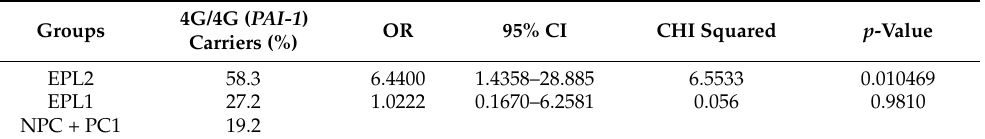
Table 5. Statistical data on the prevalence, odds ratio, 95% confidence interval, chi-squared, and p -value of 675 4G/4G ( PAI-1 ) genotype carriage in EPL1 and EPL2 groups versus healthy pregnant and non-pregnant controls (NPC + PC).